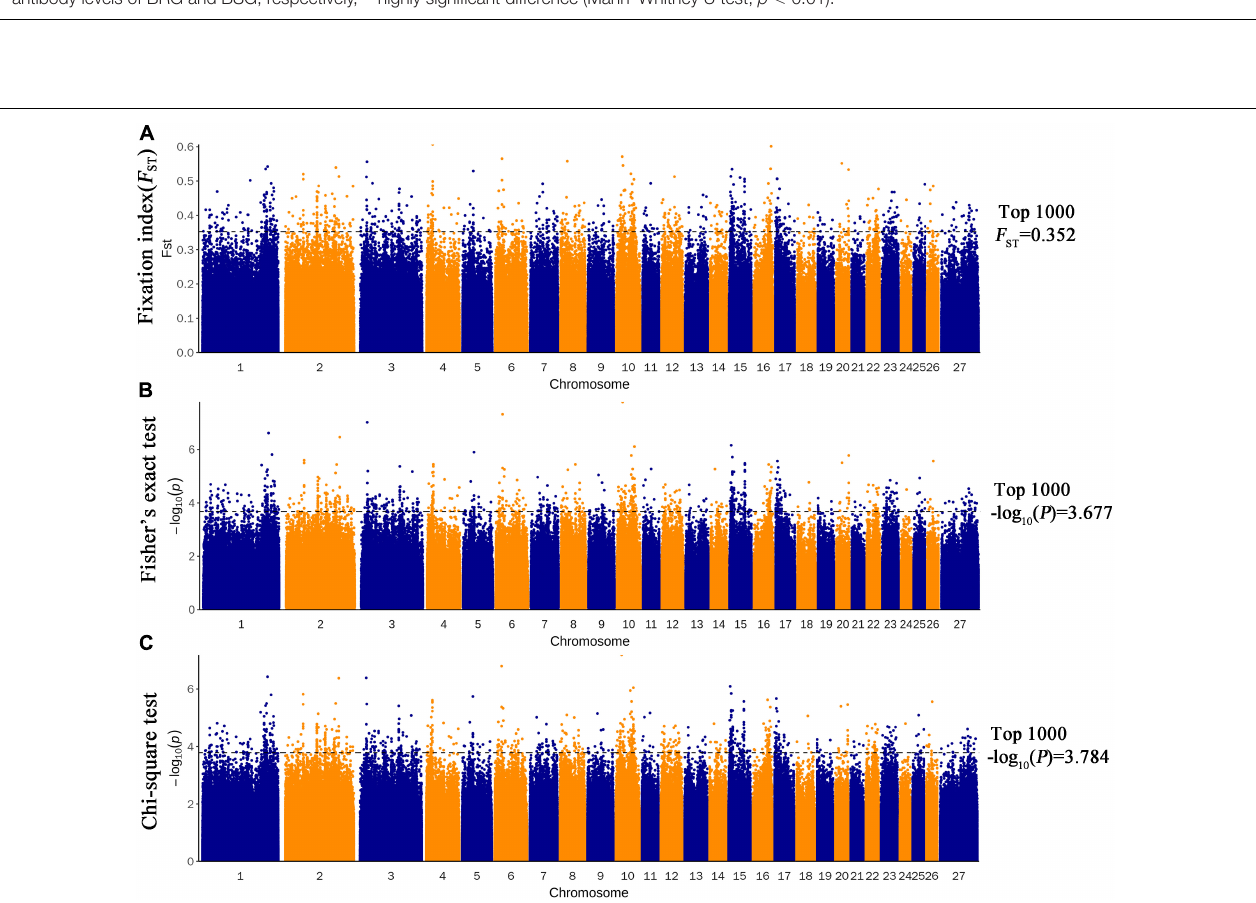
FIGURE 2 | Genome-wide distribution of F ST (A) , Fisher’s exact test (B) , and chi-square test (C) . The horizontal black line in the figure shows the values for the first 1,000.